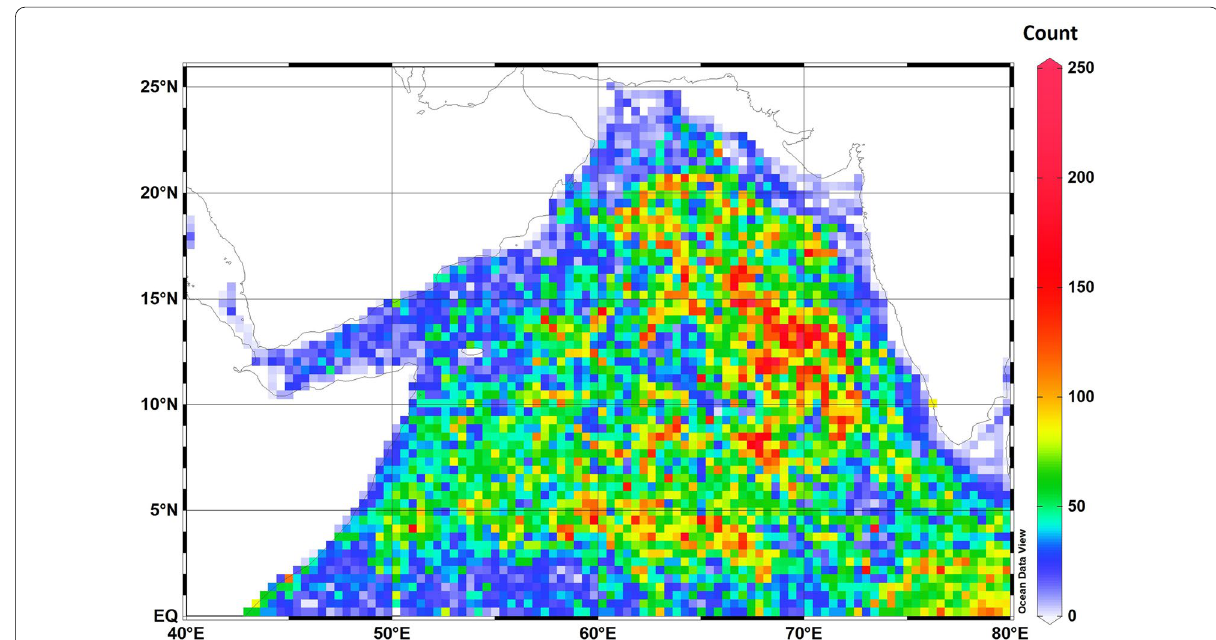
Fig. 2 Number of drifters in each 1/3°